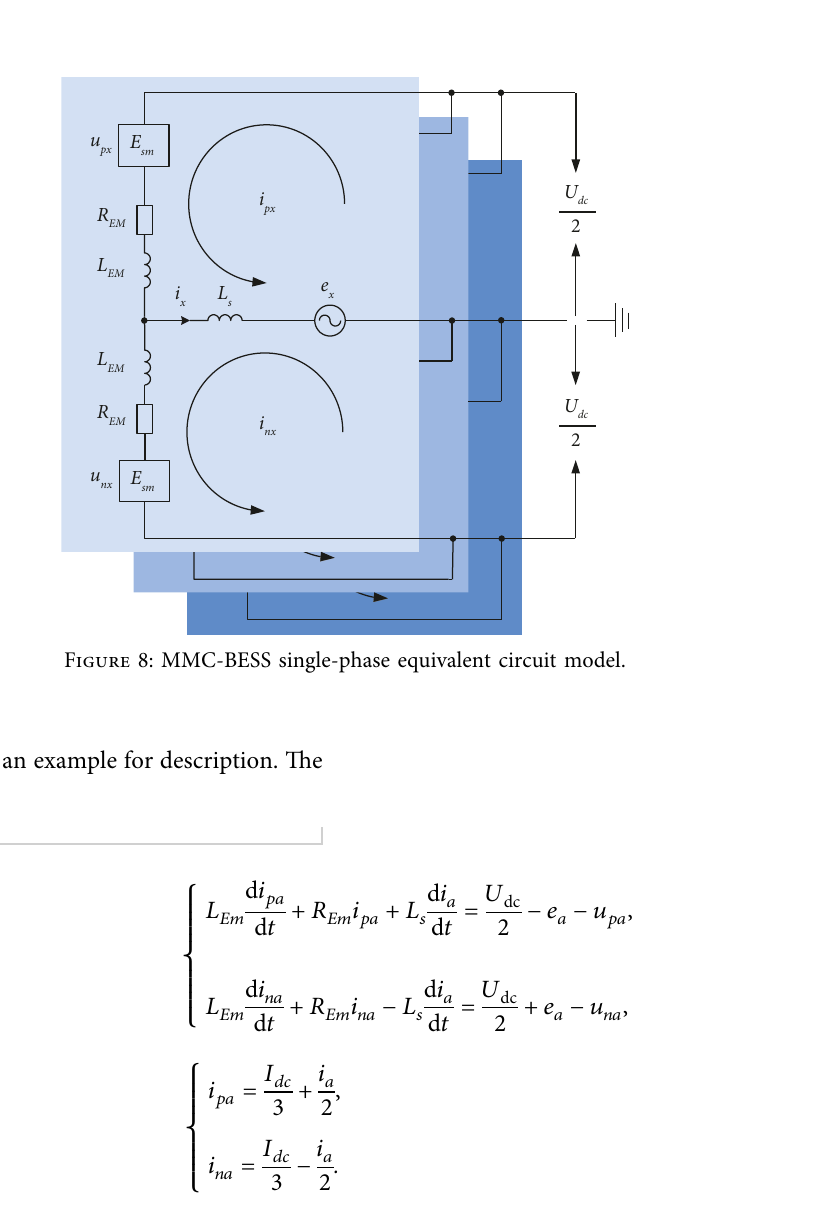
Figure 7: MMC-BESS hierarchical control system.